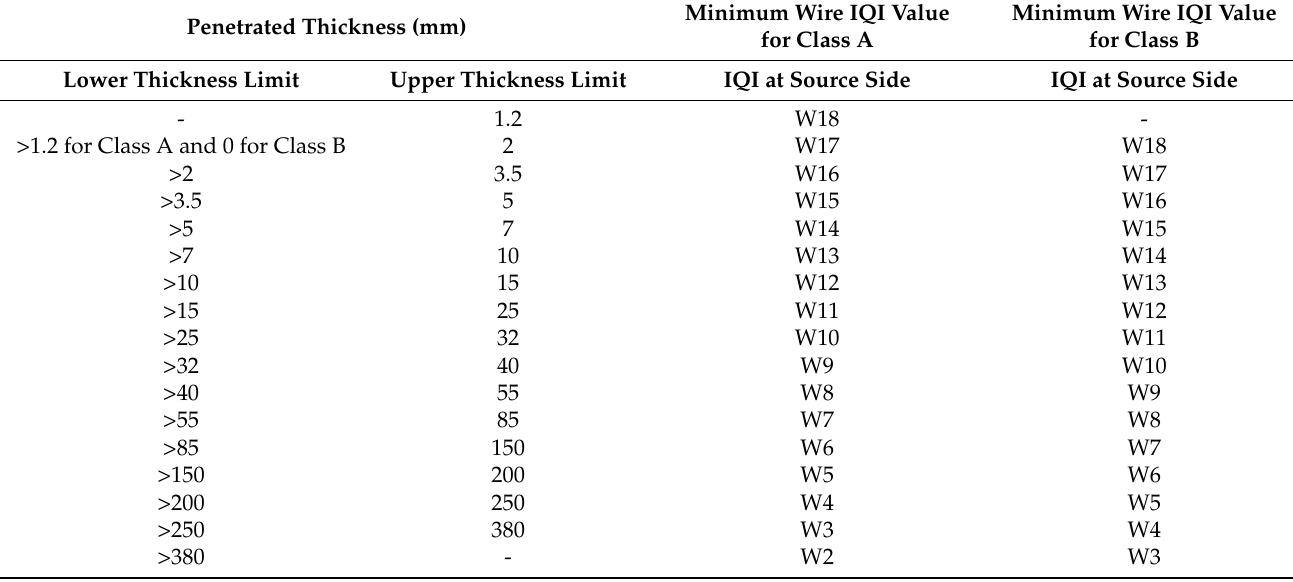
Table 2. Minimum image quality requirements for the visibility of wire IQIs for class A or